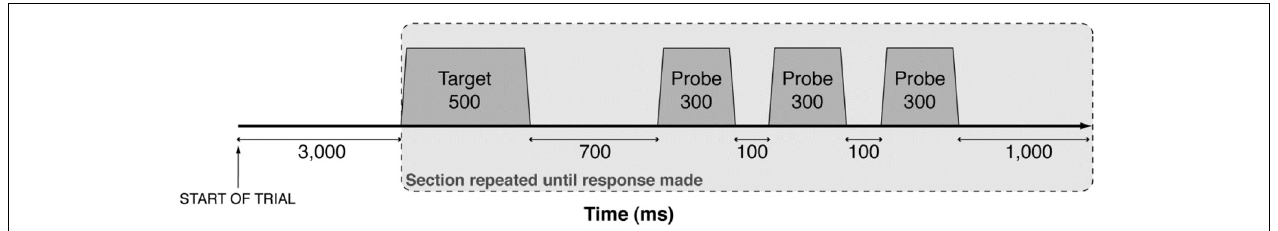
FIGURE 2 | A schematic representation of the presentation of auditory stimuli. Each target stimulus and probe were synthesised with 30ms linear onset and offset ramps and presented in a continuous sequence (gray